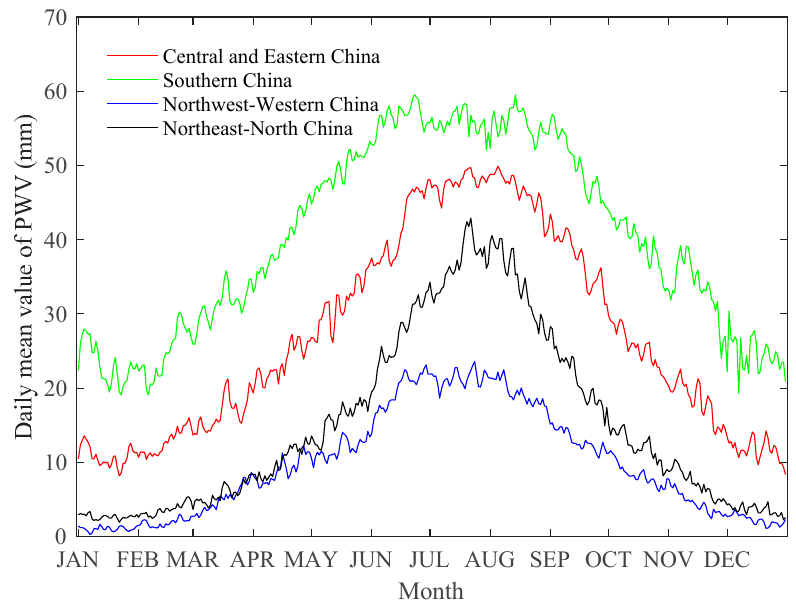
Figure 9. Nine-year averaged daily PWV (mm) in four regions of China from 2011 to 2019.